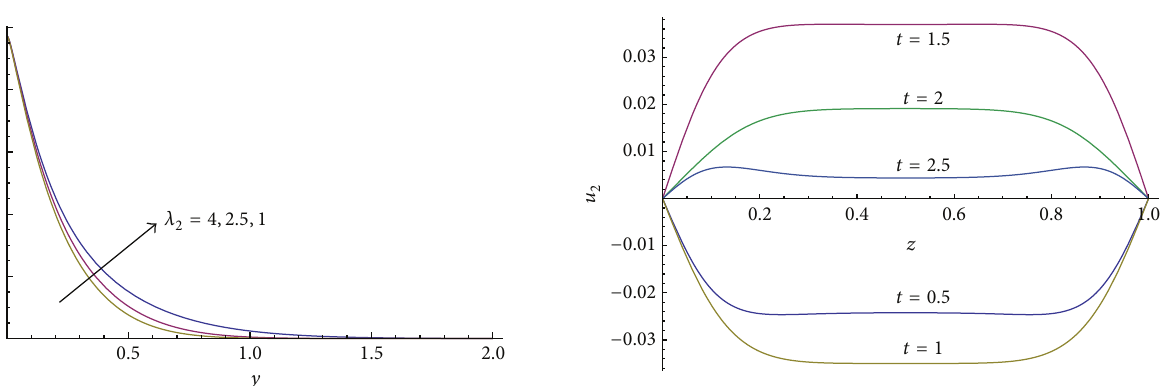
Figure 4: The influence of the material parameter 𝜆 2 on the velocity profile 𝑢 1 (𝑦,𝑧, 𝑡) with 𝑧 = 0.5 , 𝑡 = 0.1 , 𝛼 = 2.5 , 𝛽 = 0.5 , Re = 1 , = 5 , and 𝜆 = 1 . 𝜆 1 3